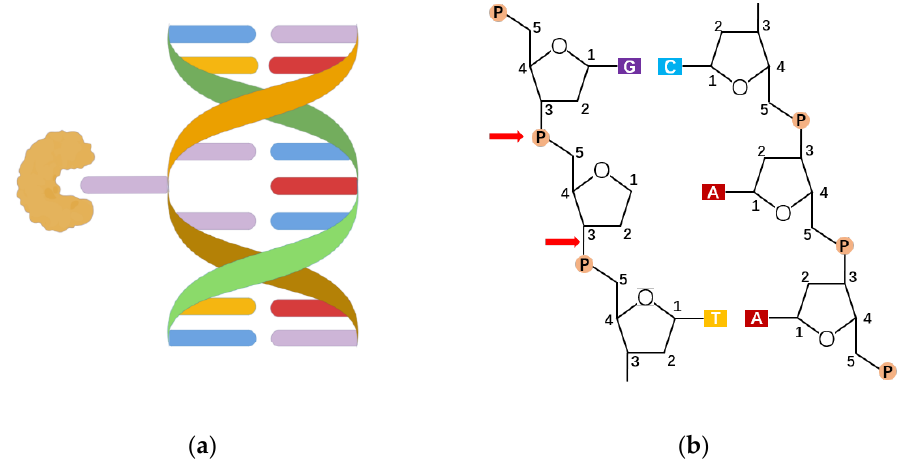
Figure 2. The recognition and excision of 8-oxoG. ( a ) The lesion-specific binding pocket of OGG1 allows the recognition of the extrahelical flipped 8-oxoG, and excises it from DNA strand (drawn by Figdraw). ( b ) OGG1 acts on a sugar-phosphate backbone to form AP-sites, generating 5 ’ P ends and 3 ’ d RP ends.